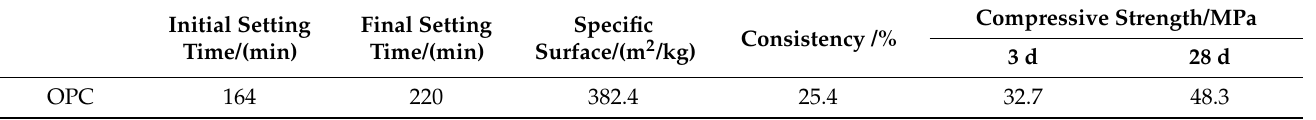
Table 2. Physical properties of